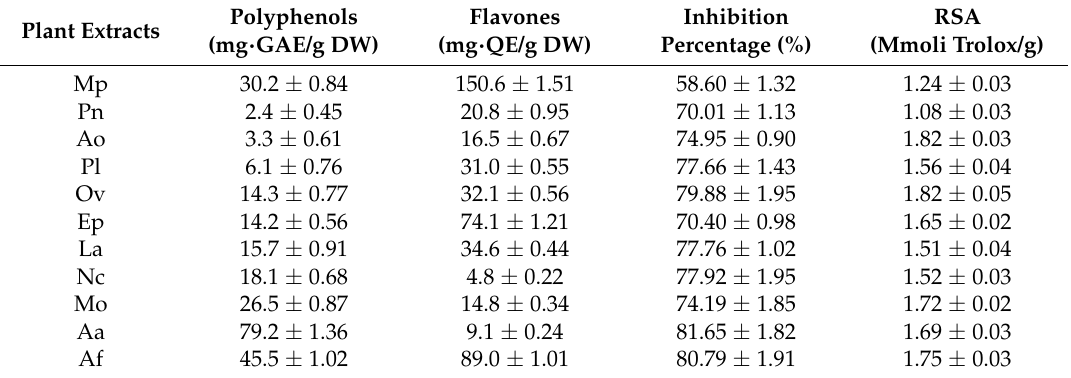
Table 1. Total Polyphenolic and Flavones Content, Radical scavenging activity of studied the plant extracts. Results are given as mean ±